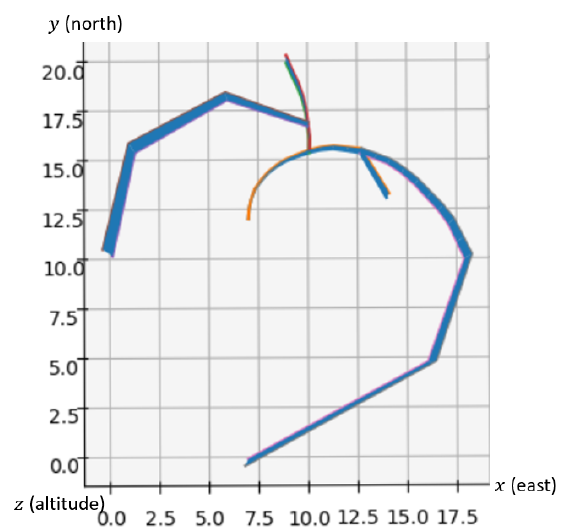
Figure 8. The Stockholm instance.